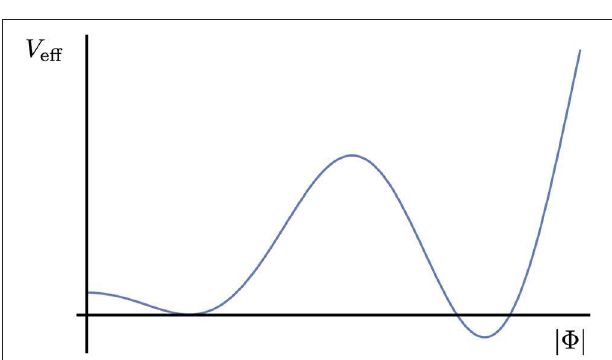
FIGURE 2 | A schematic depiction of the one-loop effective potential in the SM. This is intended only to present a general picture of the minima and is not to